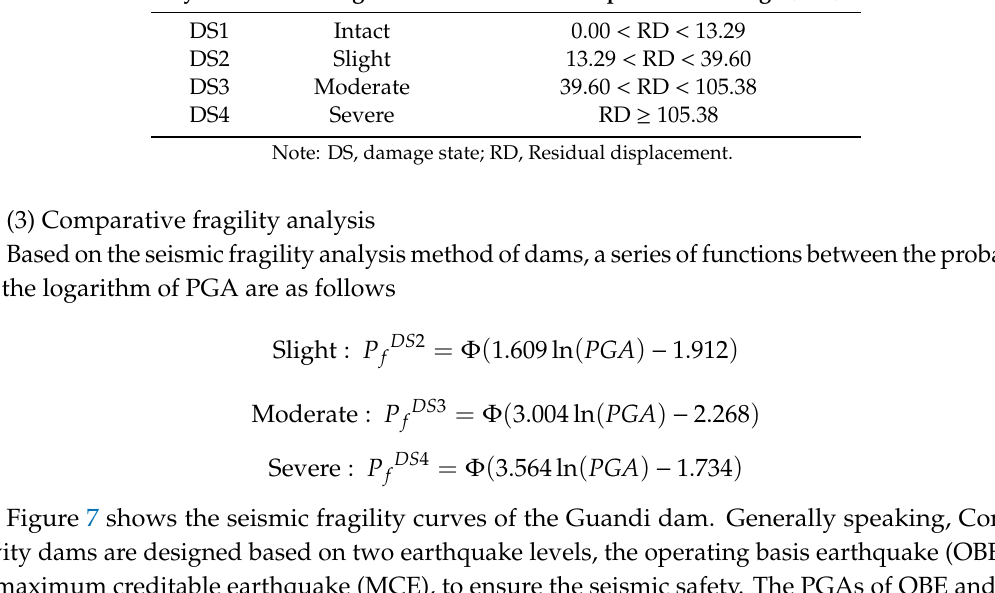
Table 6. Residual displacement-based classification of seismic damage.